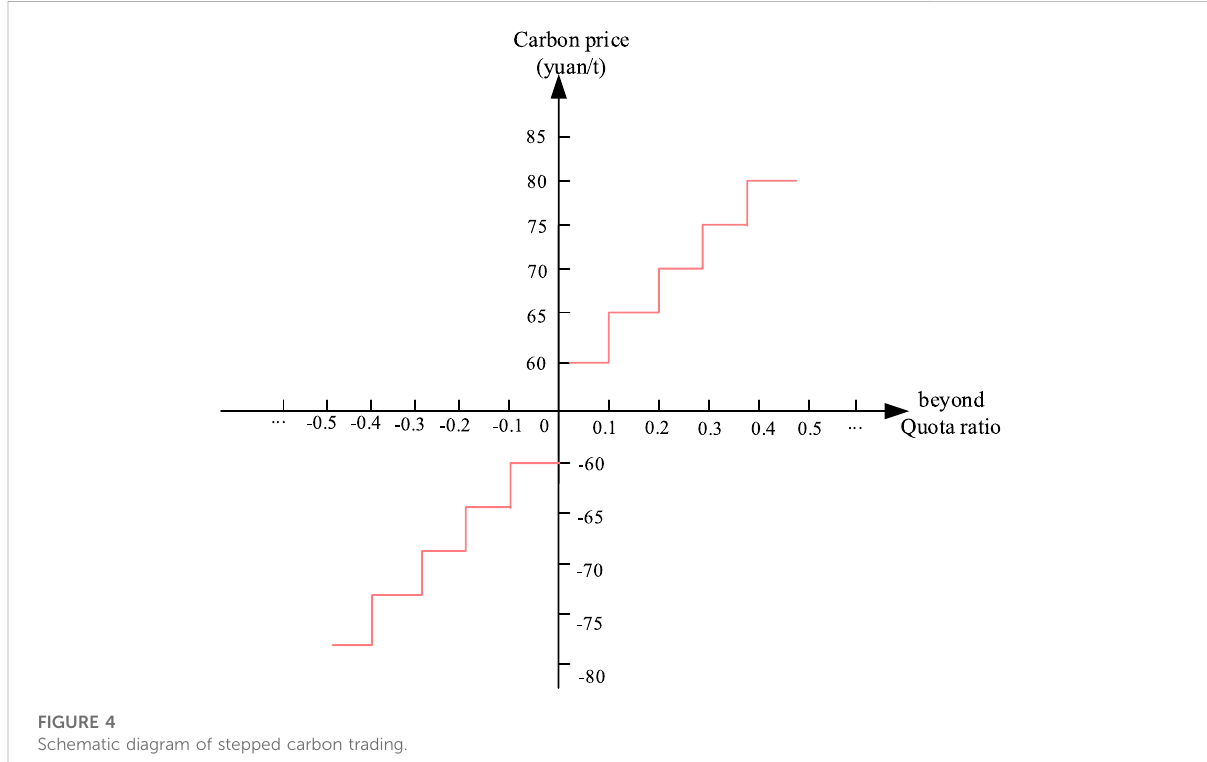
FIGURE 4 Schematic diagram of stepped carbon